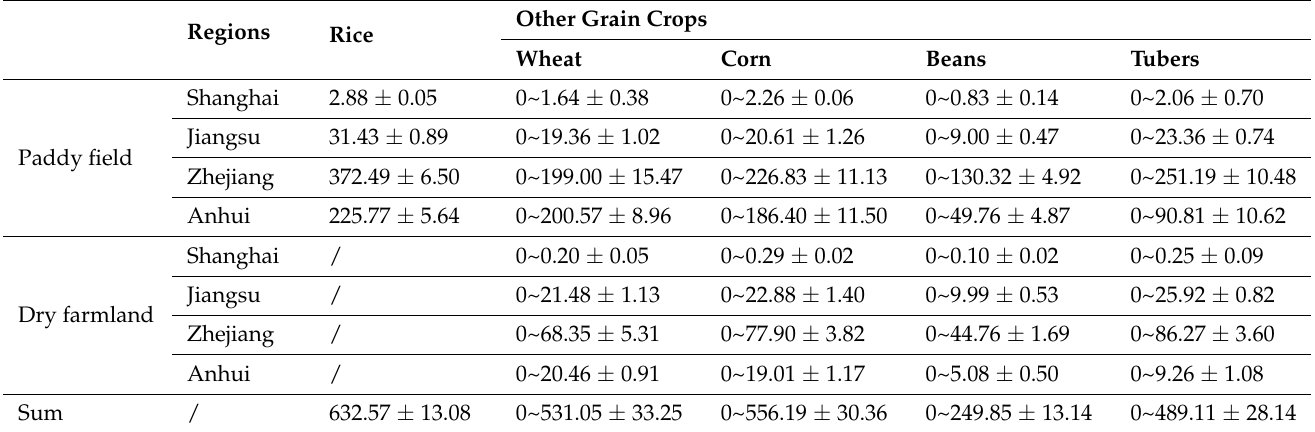
Table 5. Annual increment of grain crops after the implementation of the land returning policy ( × 10 4 tons). Other Grain Crops Regions Rice Wheat Corn Beans